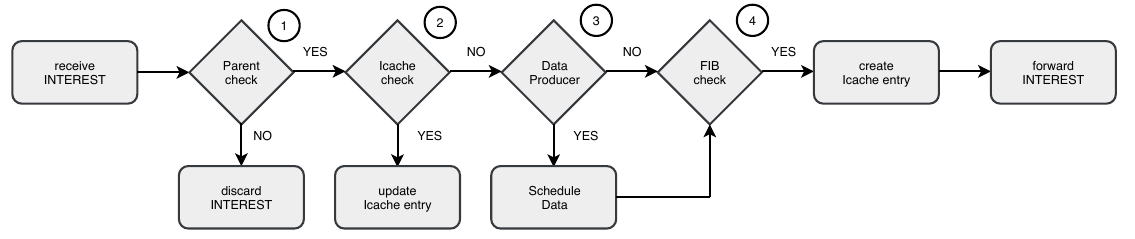
Figure 5. Interest message processing and forwarding in